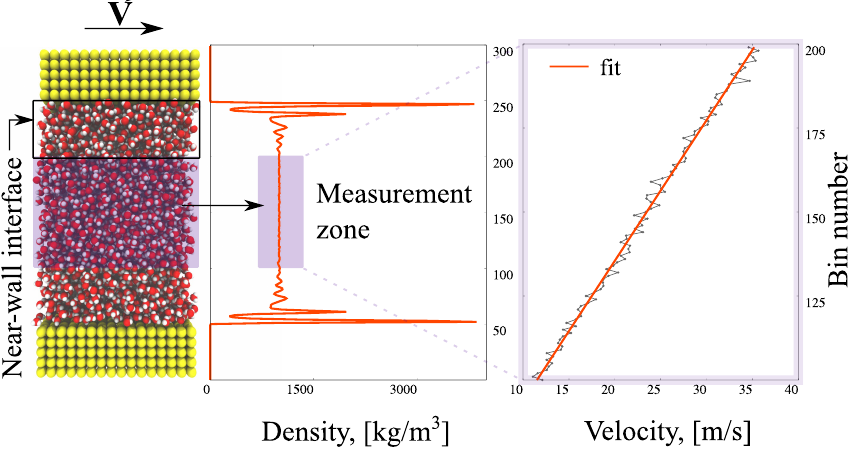
Figure 1. Schematic representation of viscosity measurement in non-equilibrium molecular dynamics (NEMD)